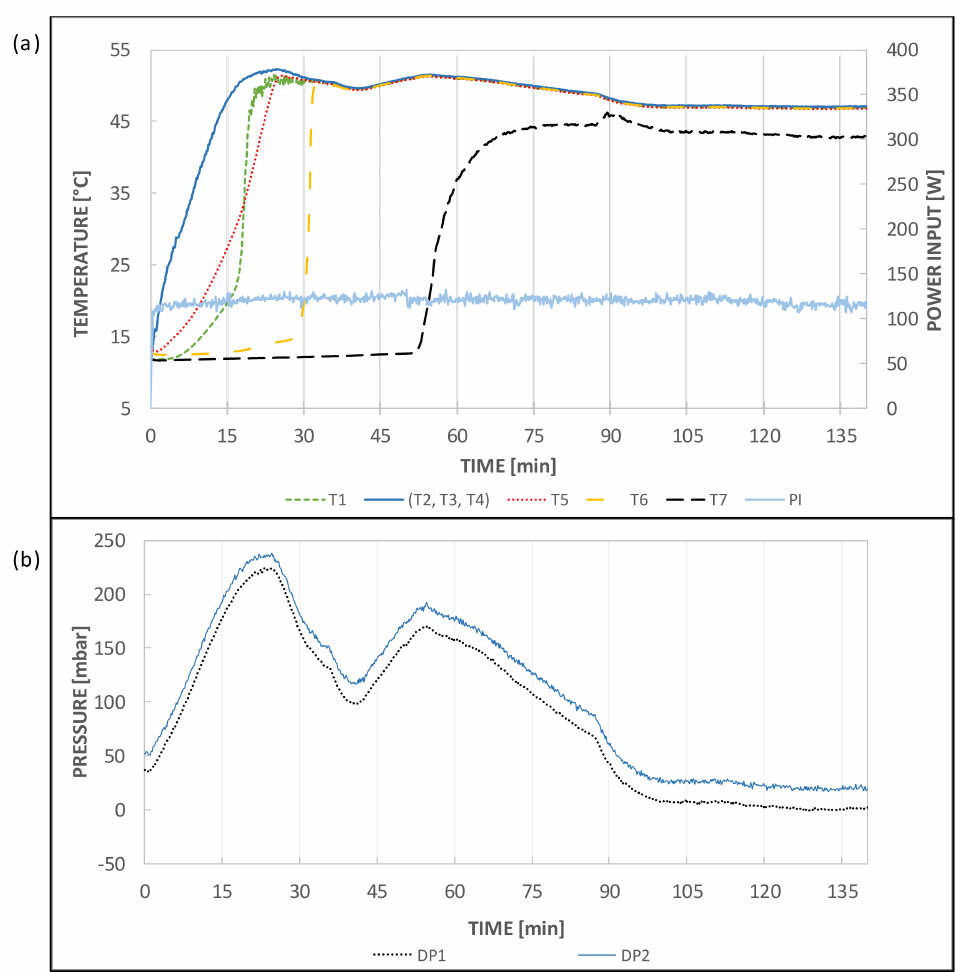
Figure 2. ( a ) Transient evolution of main temperatures and ( b ) pressures inside the CLTPT for a power input of 120